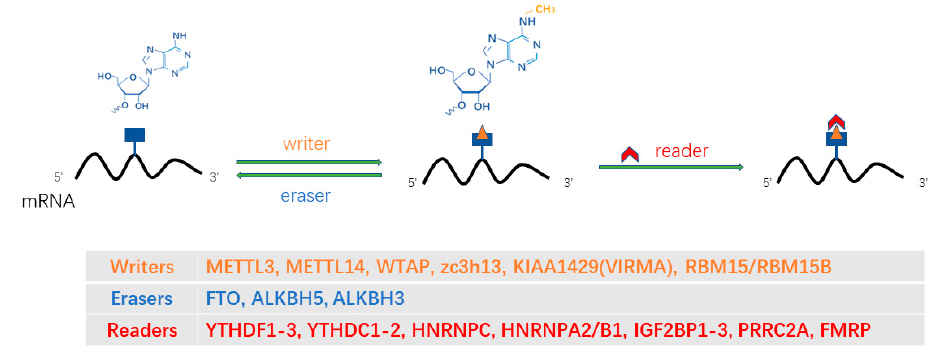
Figure 2. m 6 A modification and related proteins. “Writers” for catalytic modification deposition, “erasers” for catalytic modification removal, and “readers” for recognizing and binding modified nucleotides.